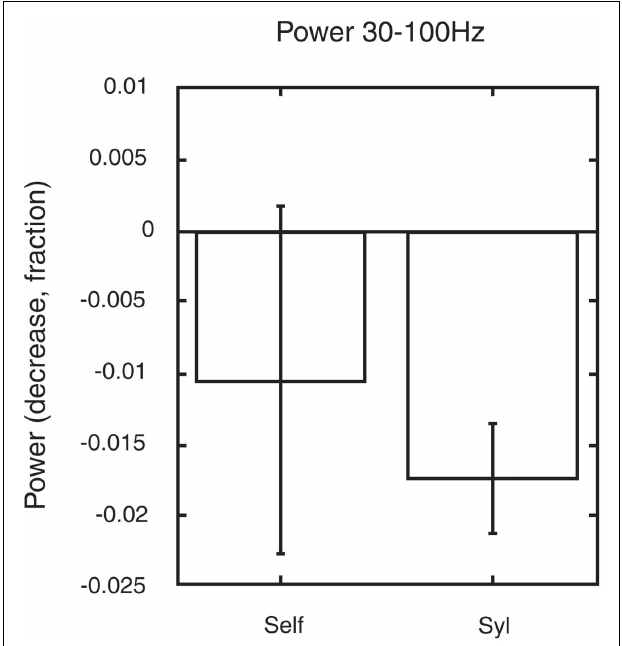
FIGURE 4 | Changes in gamma power in the paralimbic network may serve to guide allocation of brain resources. The figure shows the changes in gamma power within the paralimbic network in the pre-stimulus baseline in a task involving autobiographic memory retrieval of previous personal judgments of visually presented words. A significant decrease in gamma power ( p < 0.05) was found in minimal self-awareness (syllable counting: syl), compared to the pre-stimulus control state.This was not the case in extended self-awareness (retrieval of own previous judgment of one-self).The figure is generated from new analysis based on data from the previous experiment shown in Figure 3 (Lou et al.,